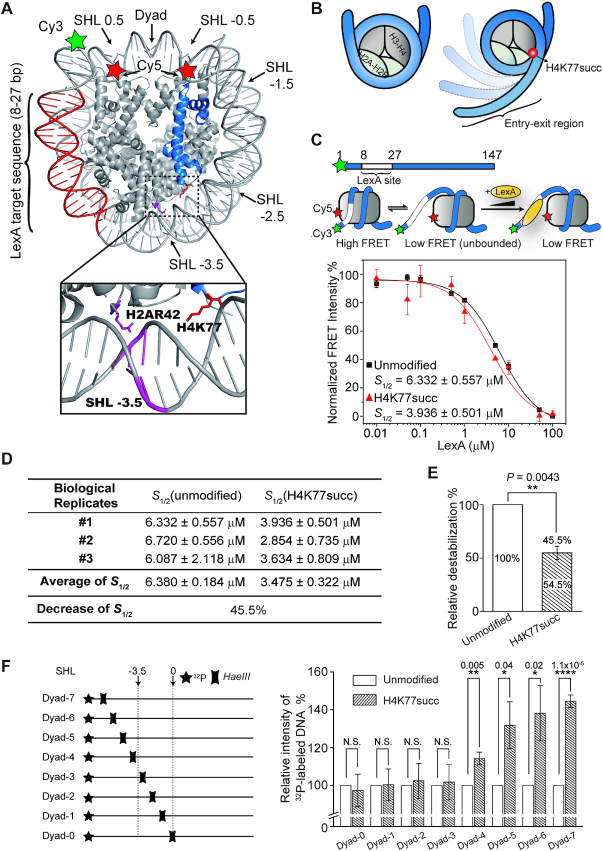
H4K77succ increased nucleosomal DNA accessibility. (A) Crystal structure of nucleosome (PDB: 3LZ1). The locations of Cy3/Cy5 FRET pair and LexA binding sites. The zoomed box shows the relative locations of H4K77 site and DNA SHL −3.5, which have strong ionic interaction with H2AR42 site. (B) Cartoons show succinylated H4K77 enhances the accessibility to nucleosomal DNA at the entry-exit region. (C) Upper: Diagram of DNA used to reconstitute the nucleosomes. The DNA is a 147 bp 601 nucleosome positioning sequence with a LexA binding site from 8–27 bp and labeled with Cy3 at the 5′ end; Middle: A three-state model for LexA binding to its target site within a nucleosome. Lower: Plot shows the normalized FRET intensity as a function of LexA concentration for unmodified H4 (black) and H4K77succ (red) nucleosomes. The LexA concentration at which the FRET decreases by 50% is denoted as S1/2. For visualization, all curves were normalized between 100% at the maximum FRET value and 0 at highest LexA concentration. Titration was repeated three times for each type of nucleosome (n = 3, S1/2 = mean ± s.e.m.). (D) The S1/2 values of independent experiments on each type of nucleosome are shown. The average of S1/2 (mean ± s.e.m.) was calculated from three biological replicates (independent nucleosome preparations). The decrease in S1/2 value was calculated as \documentclass[12pt]{minimal}
\usepackage{amsmath}
\usepackage{wasysym}
\usepackage{amsfonts}
\usepackage{amssymb}
\usepackage{amsbsy}
\usepackage{upgreek}
\usepackage{mathrsfs}
\setlength{\oddsidemargin}{-69pt}
\begin{document}
}{}$( {{S_{1/2}}({\rm{unmodified}}) - {S_{1/2}}({\rm{H}}4{\rm{K}}77{\rm{succ}})} )/{S_{1/2}}({\rm{unmodified}}) \times {\rm{\ }}100{\rm{\% }}$\end{document}. (E) The histogram shows the change in nucleosomal DNA accessibility associated with succinylation modification. The mean of the S1/2 values of unmodified nucleosomes was set to 100%. The P values were based on a two-tailed Student's t test. **P < 0.01. (F) A ‘one-pot’ assay to examine the accessibility of nucleosomal DNA. The nucleosomes were assembled with DNA containing HaeIII at the indicated positions. The amount of HaeIII-digested DNA was detected and quantified by phosphorimaging. The histogram shows the change of intensity of 32P-labeled DNA fragments associated with succinylation. Data are represented as mean ± s.e.m. from four independent experiments (n = 4). The mean of the intensities of unmodified nucleosome samples was set to 100%. The P values were based on a two-tailed Student's t test. *P < 0.05, **P < 0.01, ****P < 0.0001. N.S., no significance.